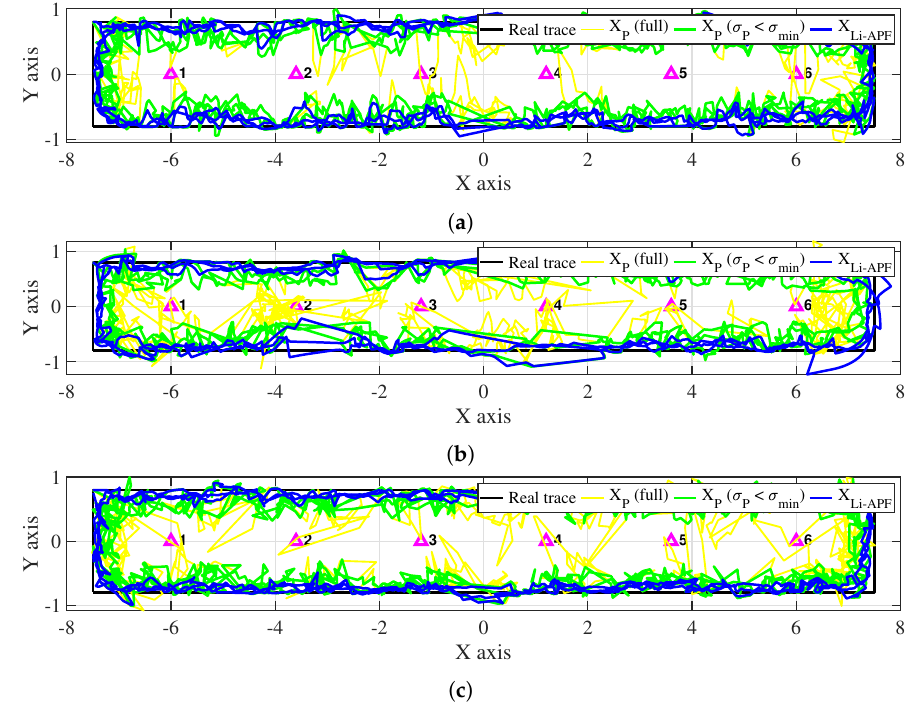
Figure 13. Experimental results in corridor environment: ( a ) Pose 1; ( b ) Pose 2; ( c ) Pose 3.